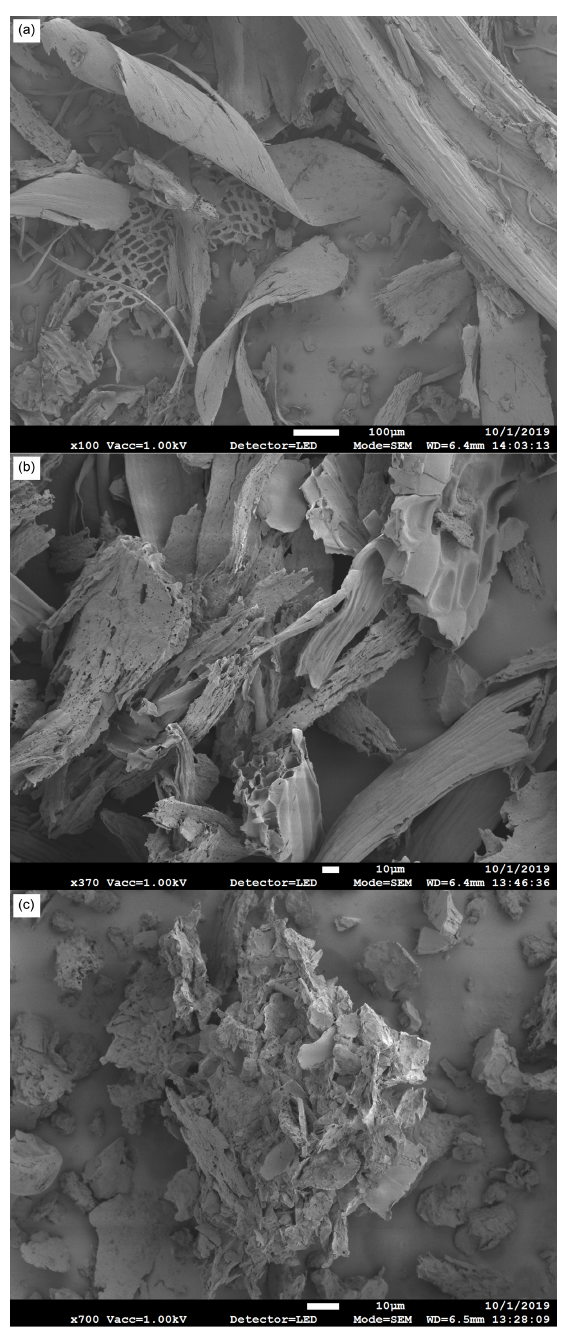
Figure 9. Scanning electron micrographs of particulate organic matter fractions: while free particulate OM fraction (a) and oc- cluded particulate OM fraction (b) consist mainly of larger particles of plant-derived litter with clearly visible cell structures and only minor indications for initial decomposition, the image of the small occluded particulate OM fraction (c) of the same sample clearly re- veals the intricate association of small organic particles and silt- and clay-sized soil